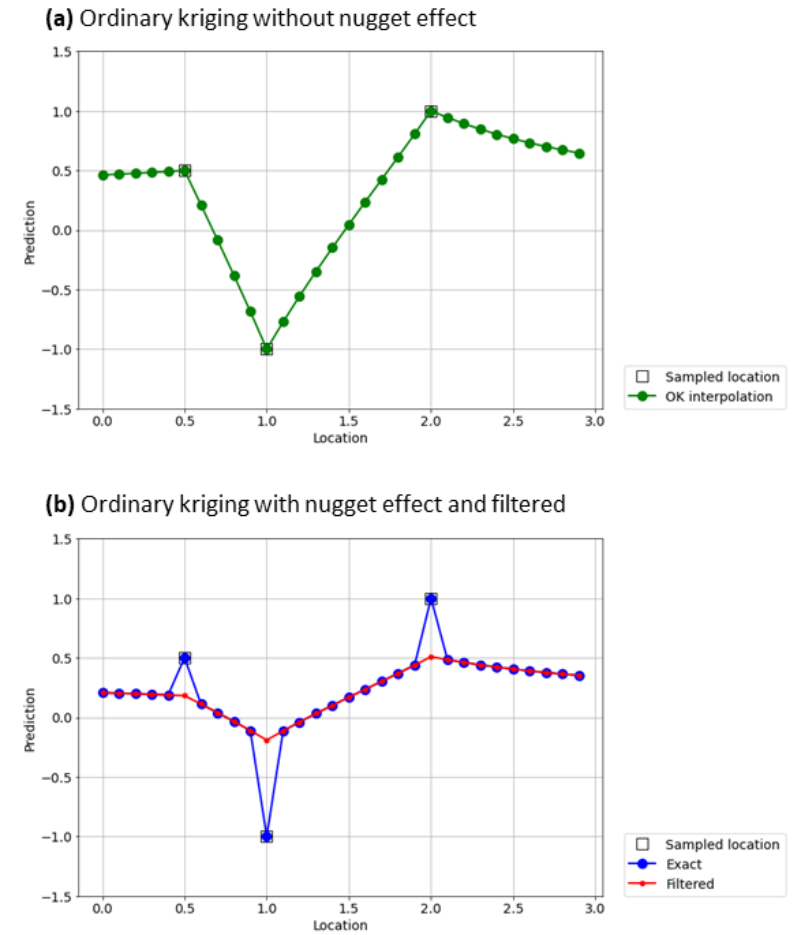
Figure 3. 1D Ordinary kriging interpolation using a exponential variogram model with range = 1 and sill = 1. Dots indicate discretized locations of interpolation. ( a ) Without nugget effect. ( b ) Nugget effect of 0.5. Blue: Exact nugget effect (small-scale variation); Red: Filtered kriging (measurement error). Adapted after K. Krivoruchko, A. Gribov, J. M. Ver Hoef